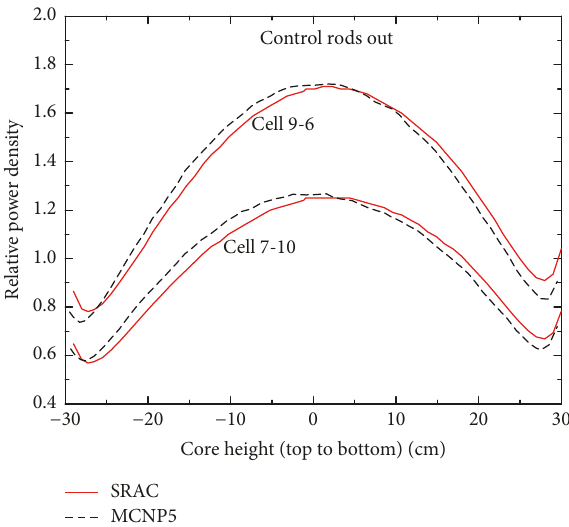
Figure 9: Axial power distribution along the fuel bundles 7-10 and 9-6 in the case of complete withdrawal of control rods.